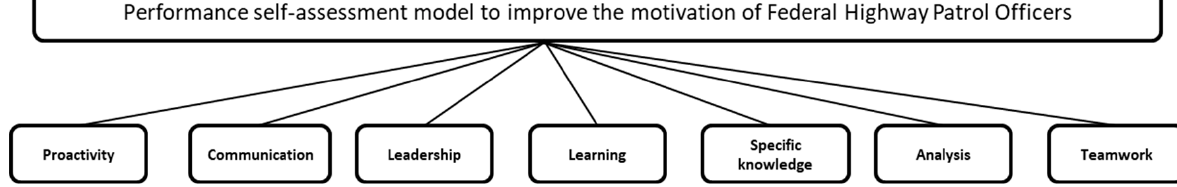
Figure 1. Value tree of FPV candidates.